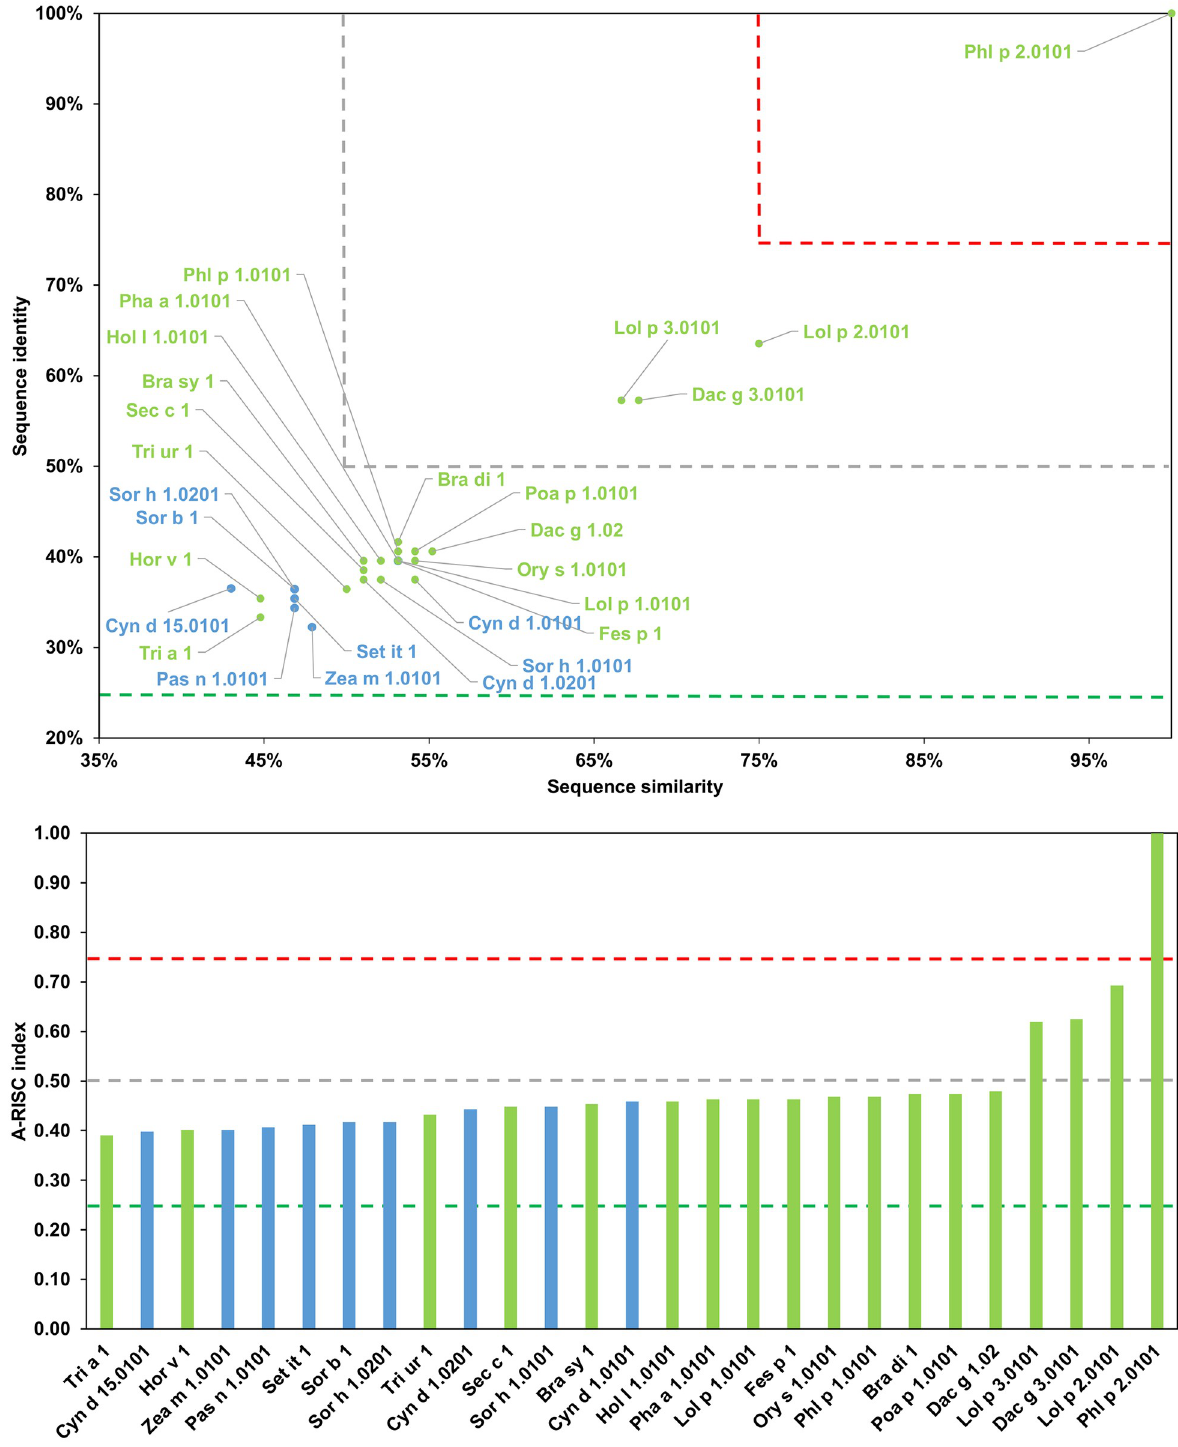
Fig 15. Plots showing relative homology and A-RISC indexes of allergens from β -expansin family of proteins. Comparison of family members to Phl p 2.0101. Temperate grasses are marked in green, while subtropical grasses are marked in blue. Red, gray and dark green dashed lines indicate respectively 75%, 50% and 25% sequence identity and similarity, or 0.75, 0.50 and 0.25 A-RISC values.